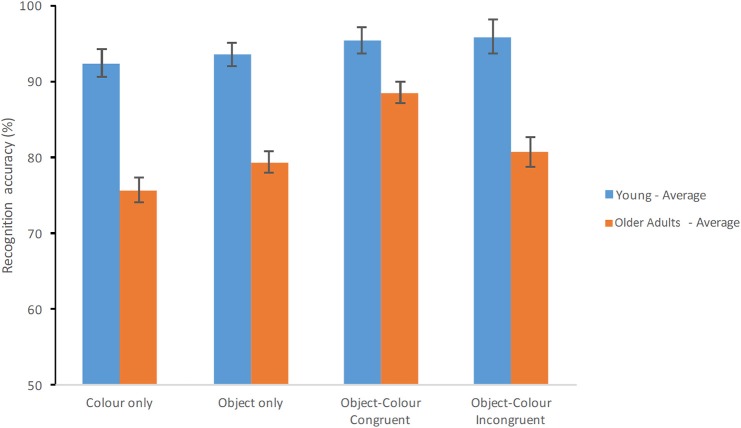
Percentage of correct recognition averaged across test delays. Average scores of young adults and healthy older adults are shown for each test condition (Error bars represent the standard error of the mean).